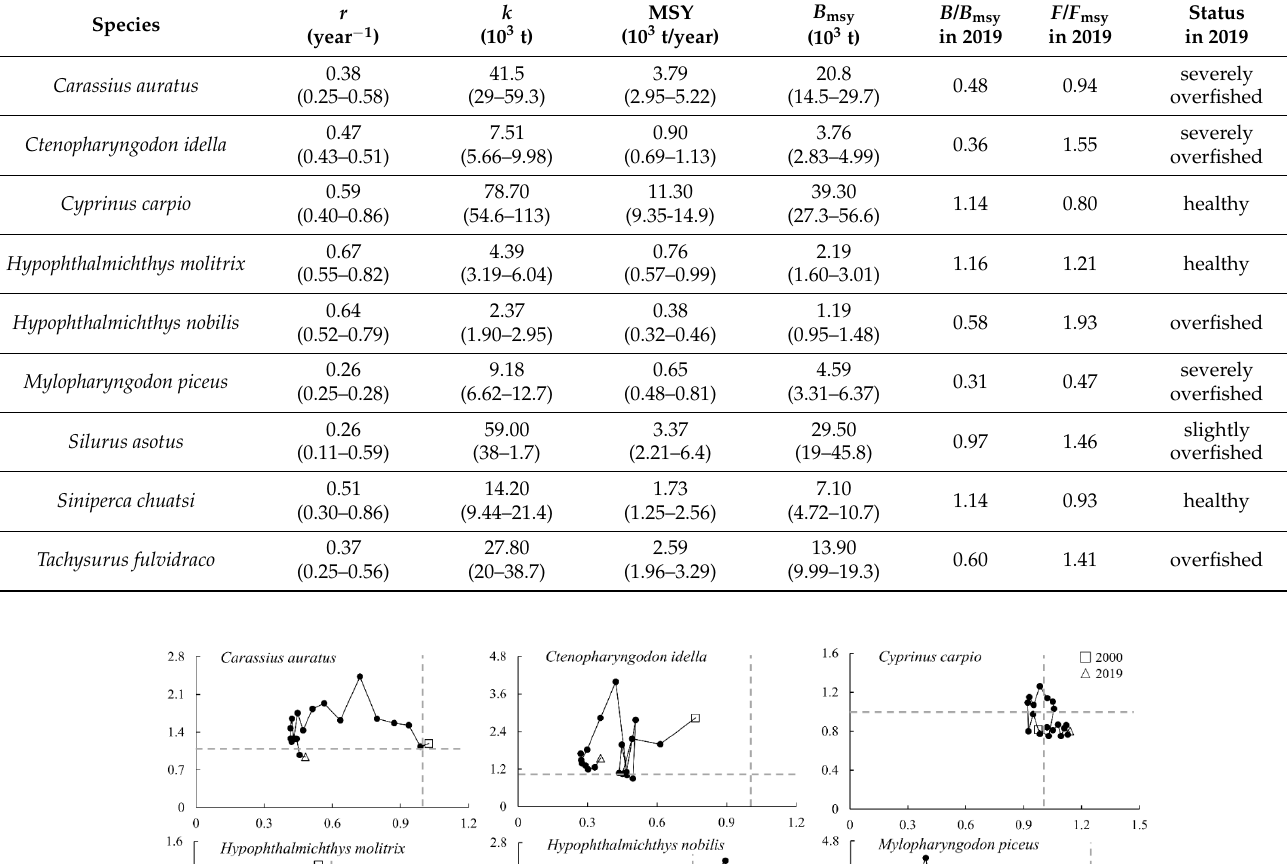
Table 1. Estimated parameters for nine main economic fishes in the Poyang Lake based on the CMSY model. Parameters r and k are population growth rate and carrying capacity, respectively. MSY indicates maximum sustainable yield. The B msy and F msy indicate biomass and fishing mortality capable of producing MSY, respectively.